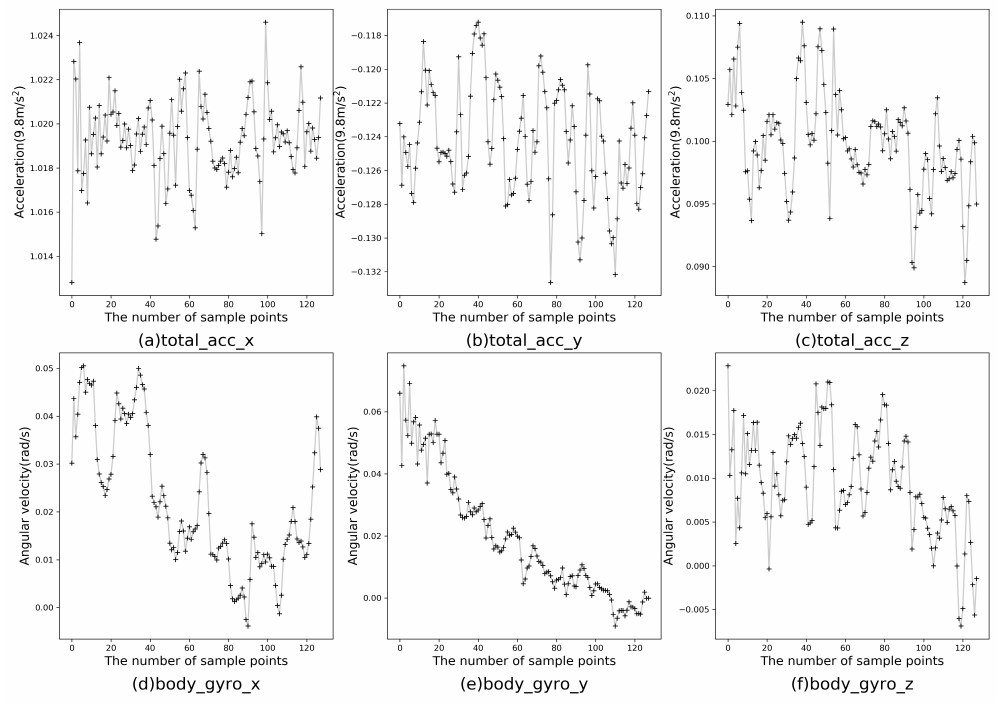
Figure 5. Three-axial linear acceleration and three-axial angular velocity: ( a – c ) the three-axis data of the accelerometer, respectively; and ( d – f ) the three-axis data of the gyroscope,